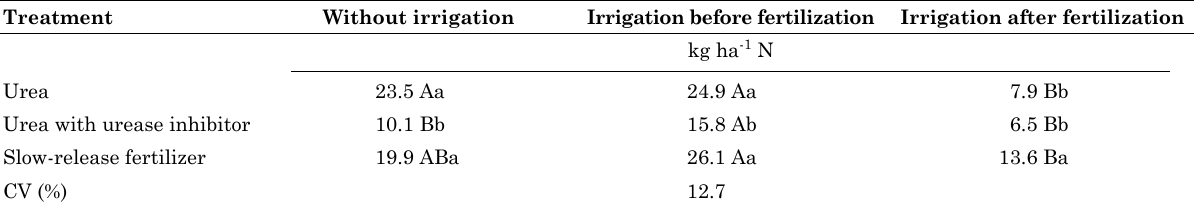
table 1. cumulative n loss by ammonia volatilization from different nitrogen fertilizers broadcast on maize in different irrigation systems